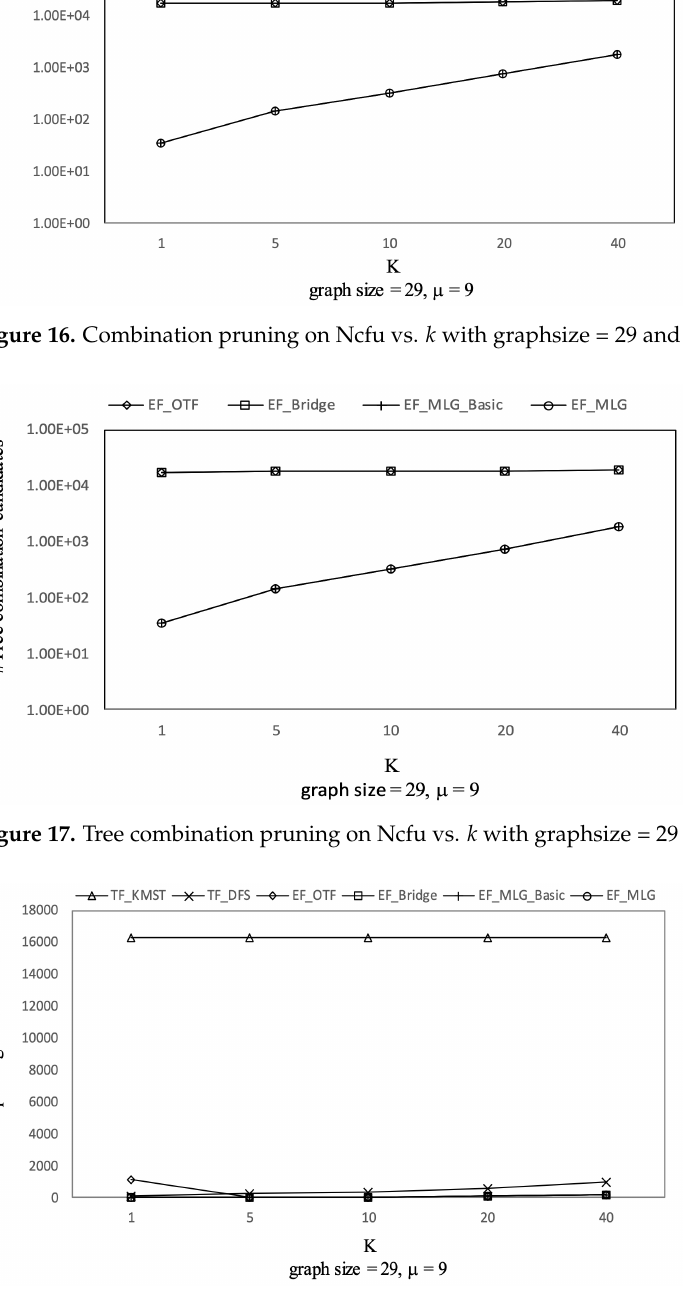
Figure 18. Spanning tree pruning on Ncfu vs. k with graphsize = 29 and µ =